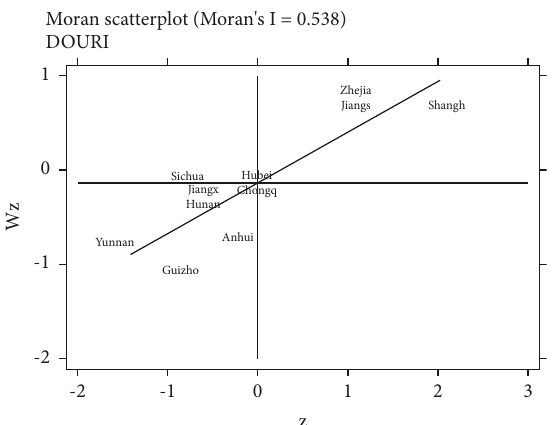
Figure 4: Distribution map of local Moran scattered points in the Yangtze River Economic Belt in 2020. Table 5: Test results for LM, LR, Wald, and Hausman tests. Statistics or null